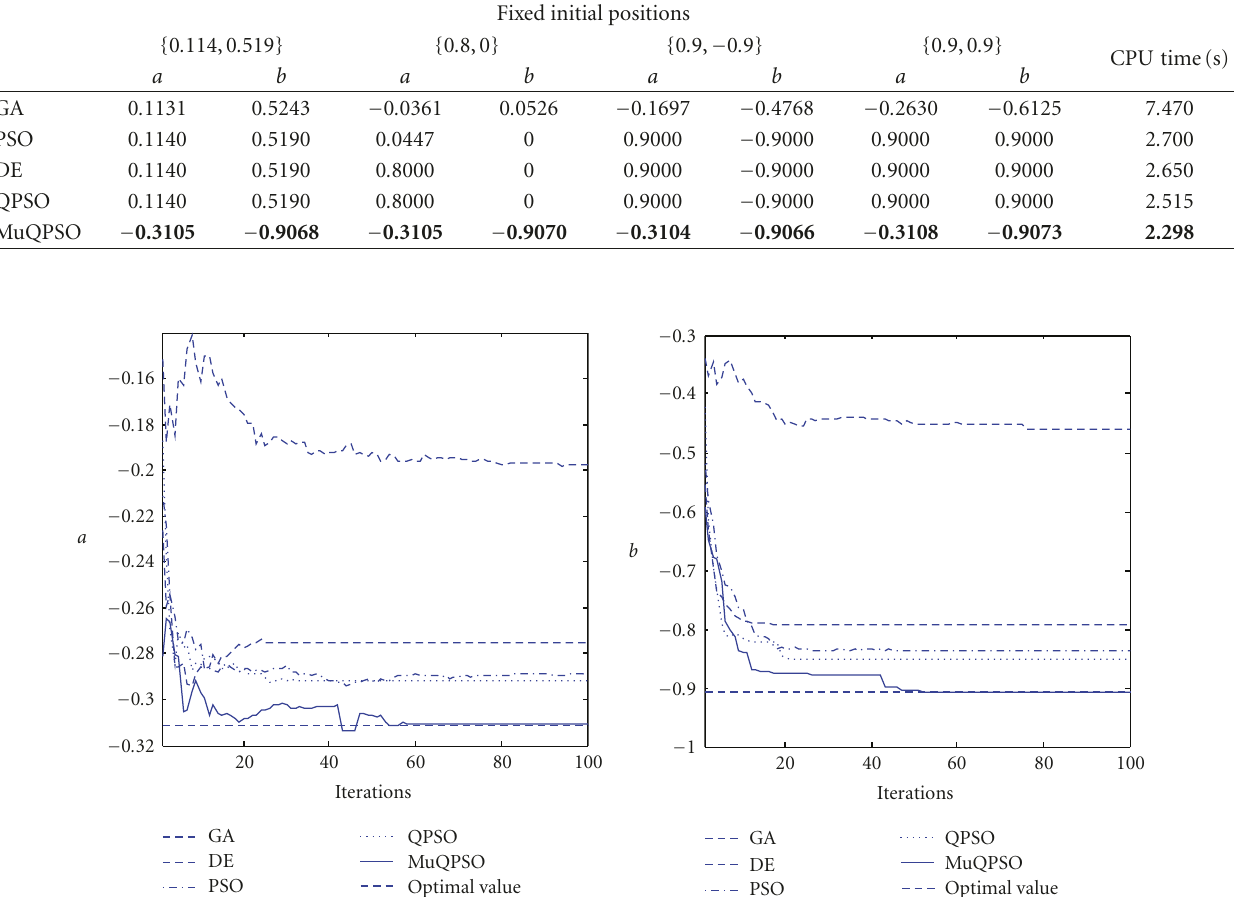
Table 4: Mean values of the filter coe ffi cients in Example 1 (mean of 100 random runs with four fixed positions).